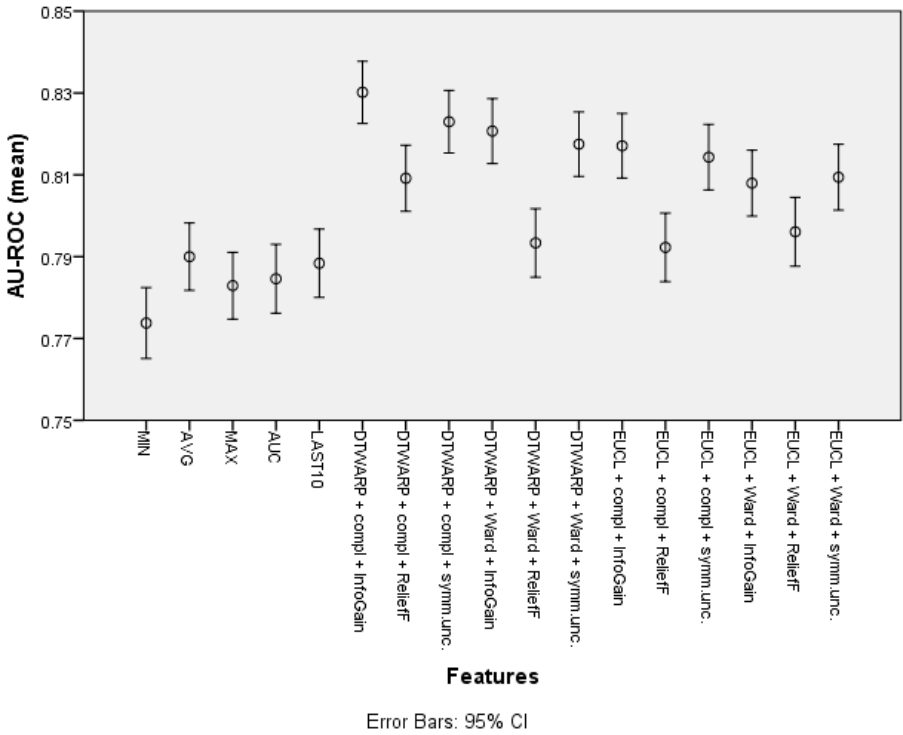
Figure 8. The area under the ROC curve of Naïve Bayes classifiers: mean values and 95% confidence intervals.